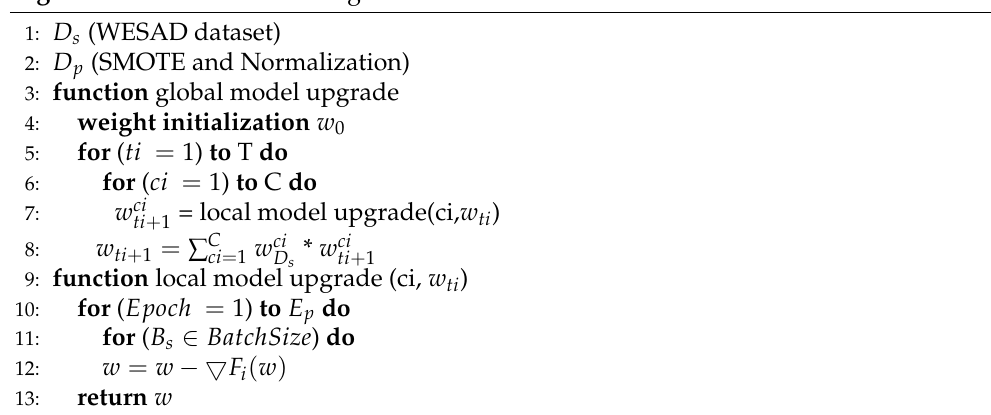
Algorithm 1 Federated learning framework for stress